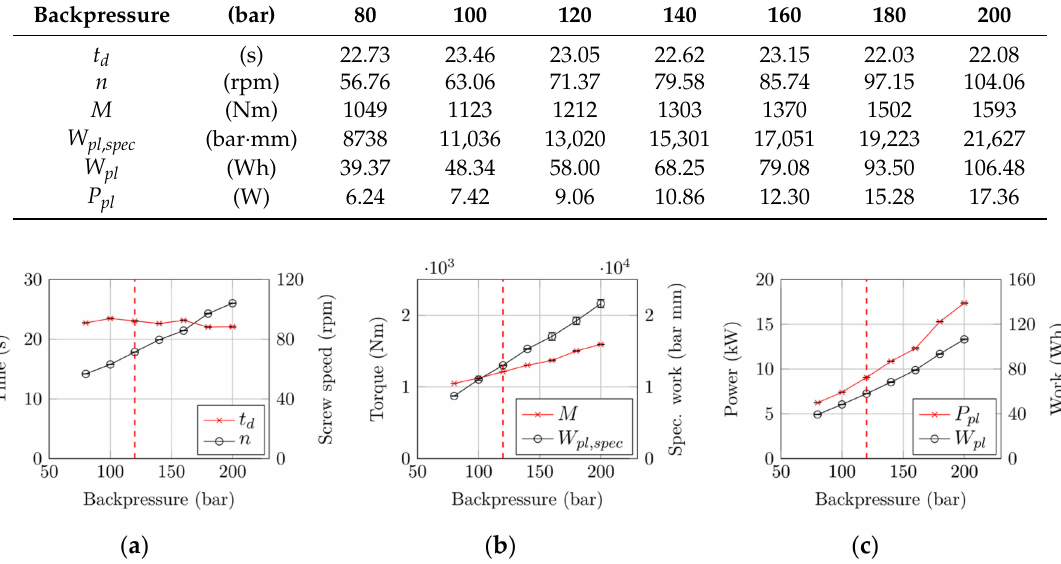
Figure 8. Relationships between various performance parameters and backpressure during plasticization for assessment of sustainability potential: ( a ) Plasticizing time, screw speed; ( b ) torque, area-specific injection work; and ( c ) plasticizing power, plasticizing